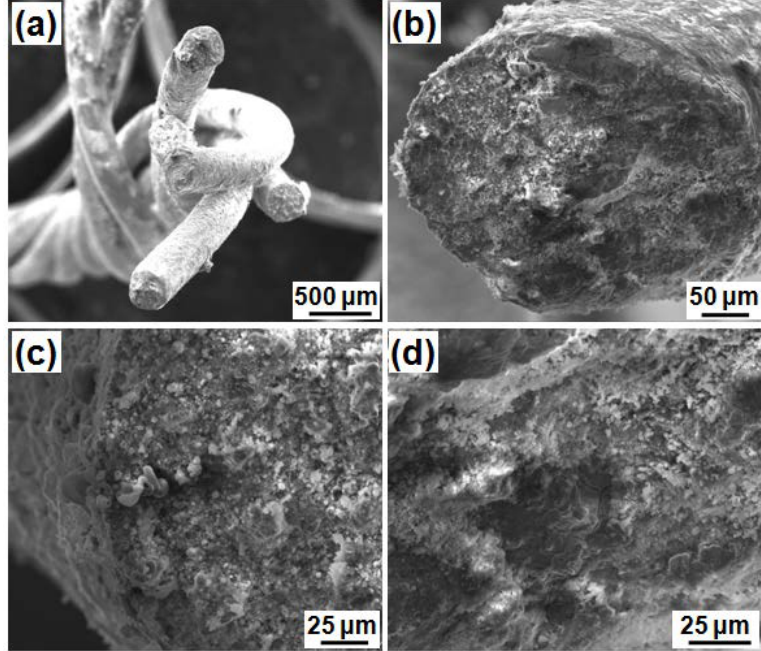
Figure 6: SEM fractographs of individual failed wire obtained at (a) Low magnification and (b-d) high magnification show thick layer deposition of corrosion debris over the fracture surface.